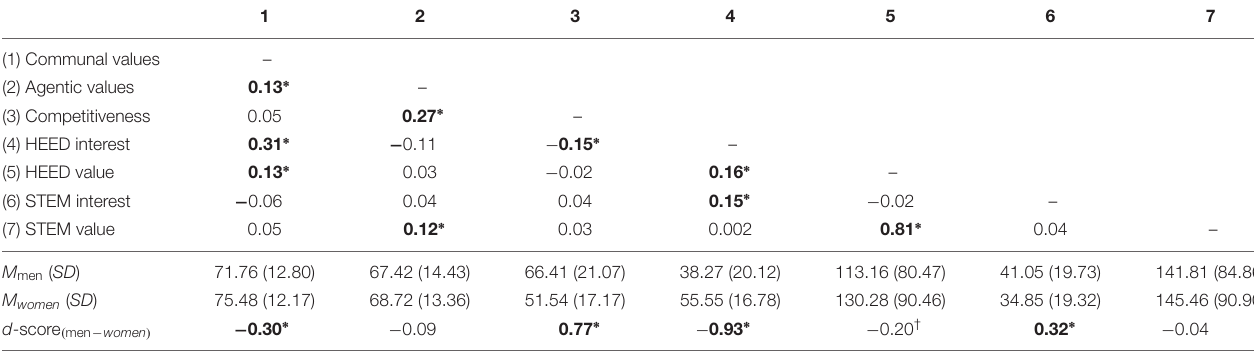
TABLE 2 | Study 2 descriptive statistics and bivariate